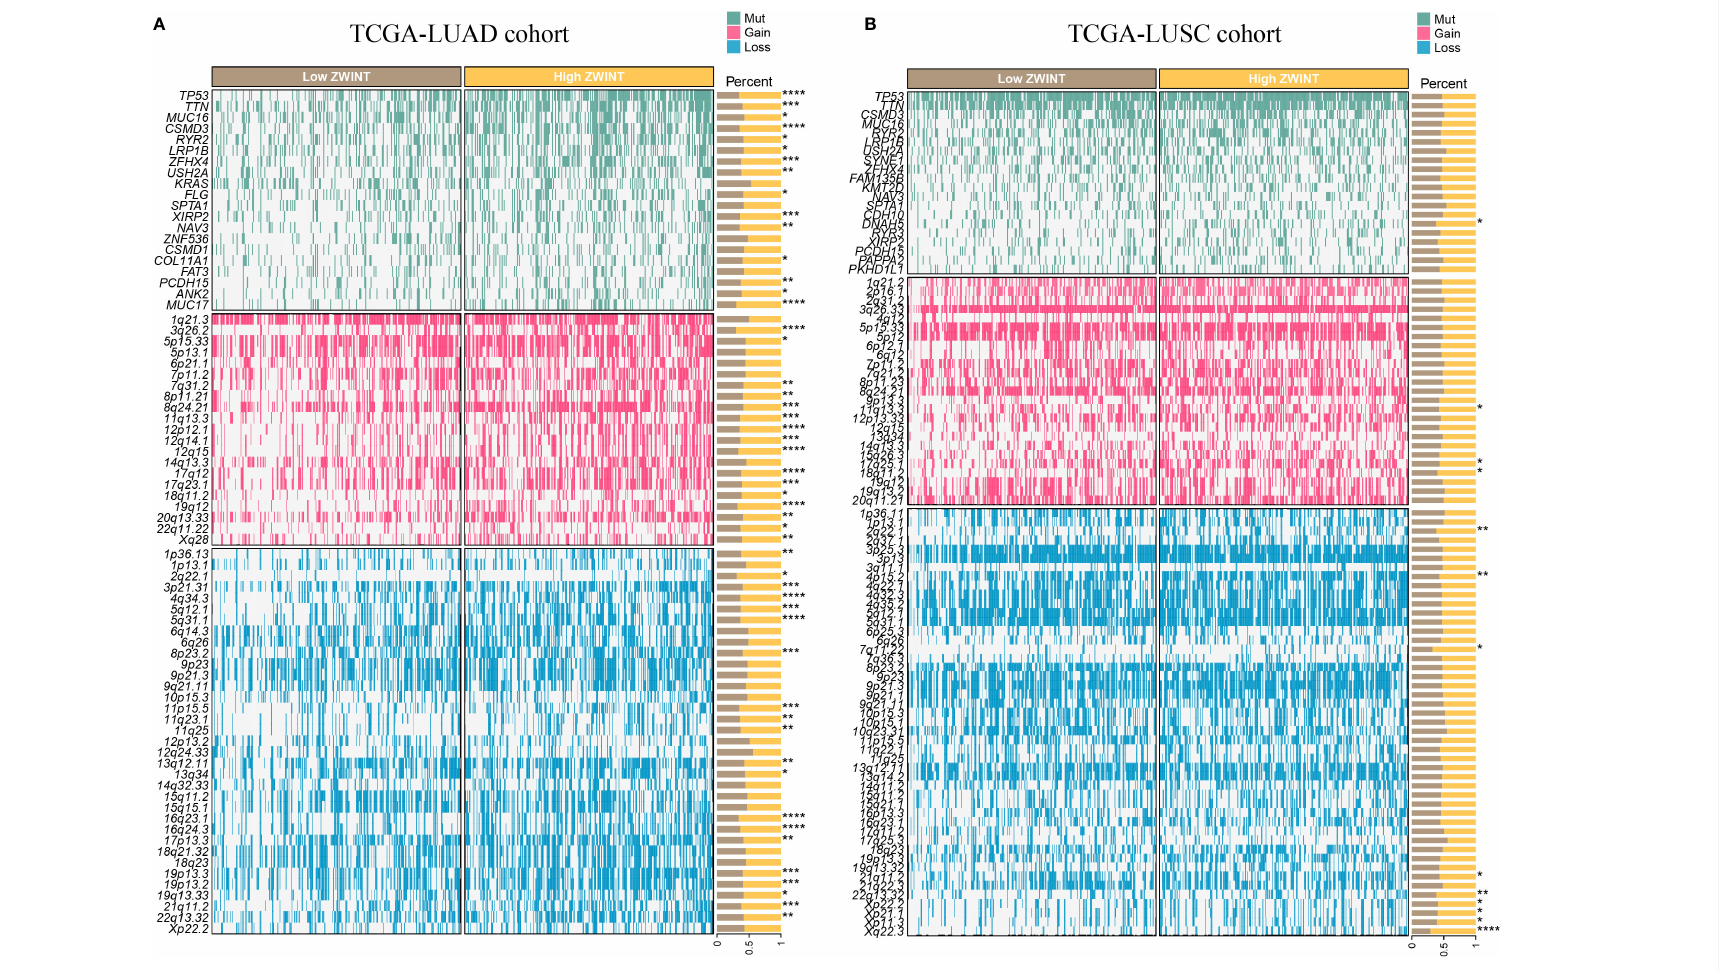
FIGURE 9 (A) Genomic mutation data of LUAD patients with varying ZWINT expression levels. (B) Genomic mutation data of LUSC patients with varying ZWINT expression levels. * indicates p < 0.05; ** indicates p < 0.01; *** indicates p < 0.001; and **** indicates p <